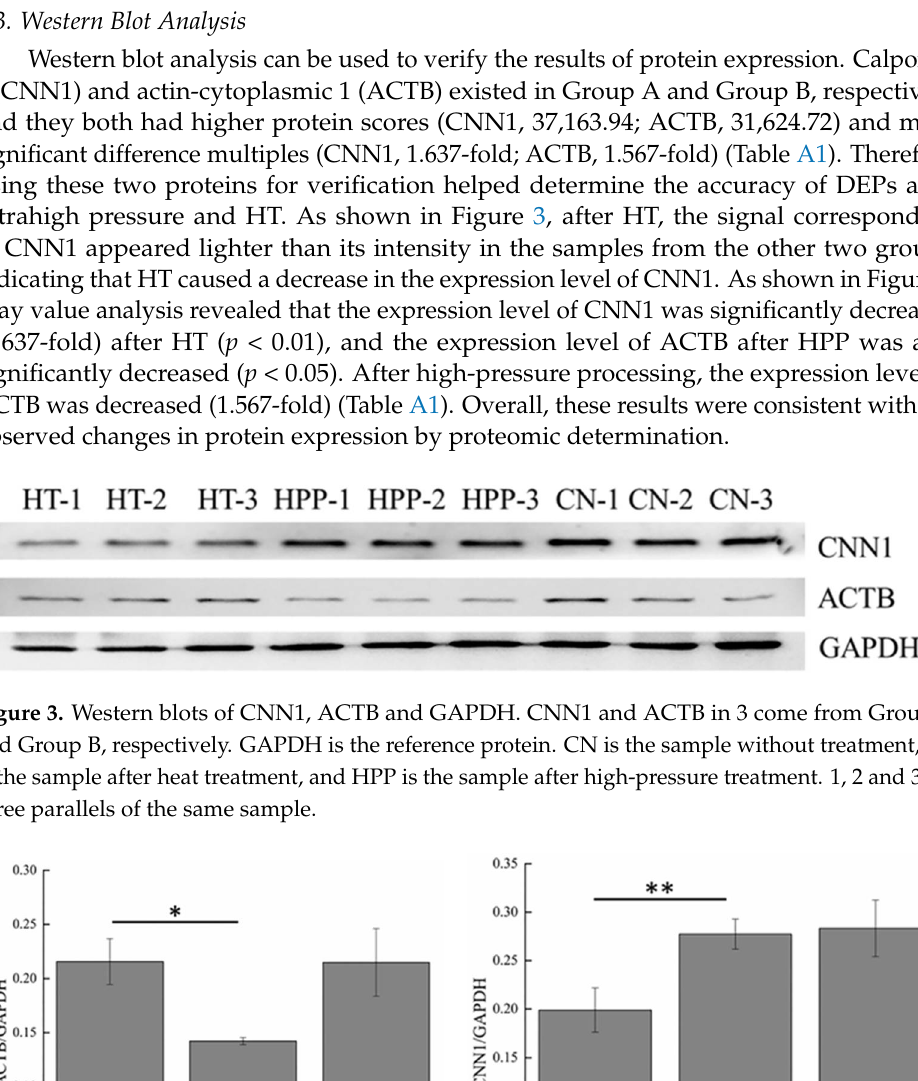
Figure 2. Venn diagram of DEPs. The quantities of differential proteins after treatment are clearly shown in Figure 2.